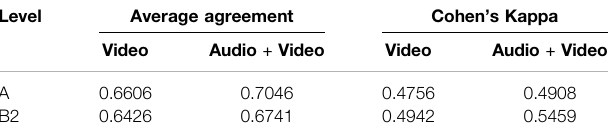
TABLE 2 | Inter-rater reliability (IRR)